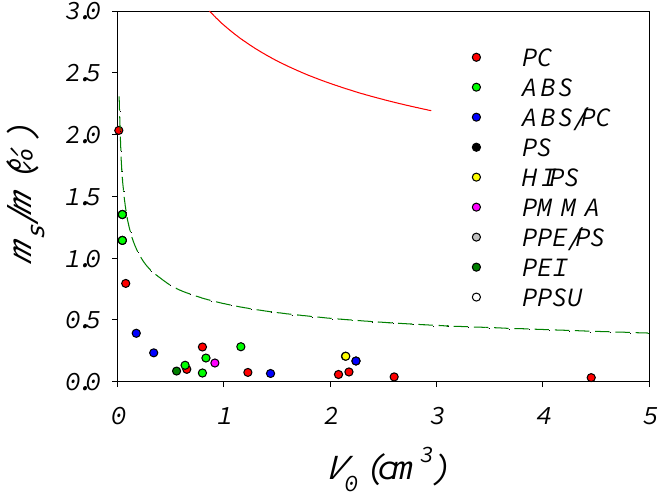
Fig. 2. An alternative representation of data from Figure 1 showing m  /m versus volume (V 0 ) for smaller